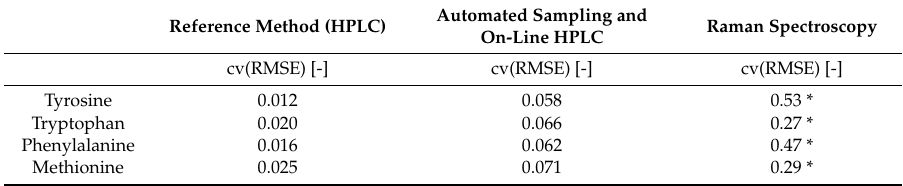
Table 2. Comparison of the cv (root mean square error (RMSE)) for four amino acids, with regard to the standard HPLC reference method, the automated sampling with on-line HPLC, and Raman spectroscopy